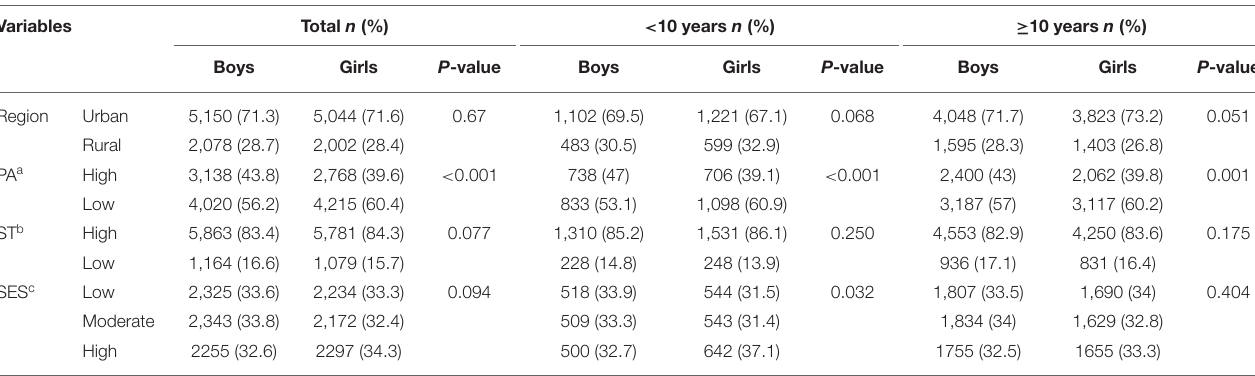
TABLE 1 | Characteristics of participants according to sex and age: The CASPIAN-V study.